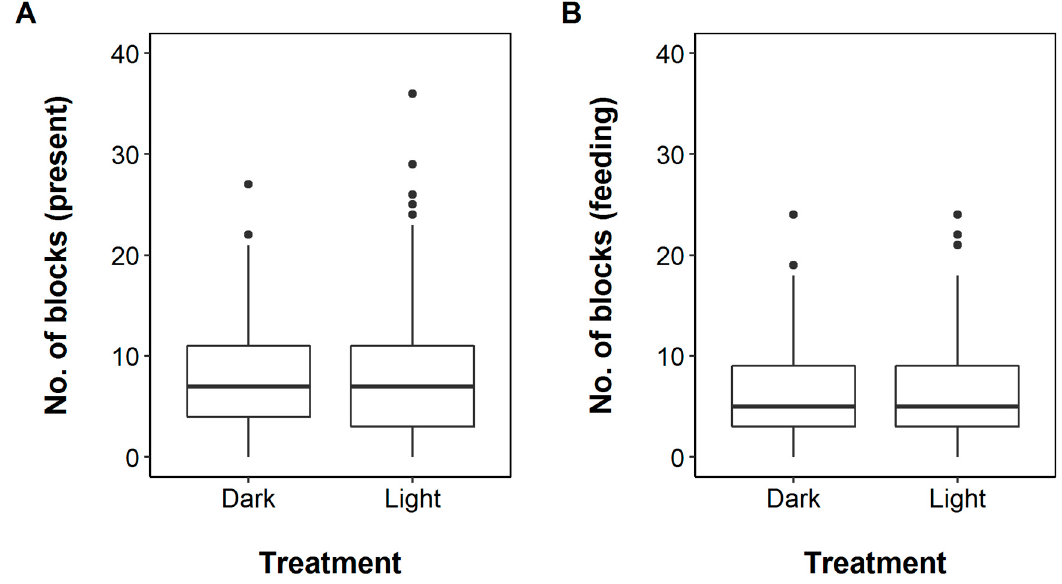
Figure 1. Box plot illustrating the e ff ects of artificial light treatments at supplementary feeding stations on hedgehog ( A ) presence and ( B ) feeding records. ‘No. of blocks’ represents the number of 10 min periods per site, per night, in which hedgehogs were present and / or feeding. The total possible number of blocks, based on night lengths, ranged from 46 to 59, with an average of 51. Plots are based on the raw